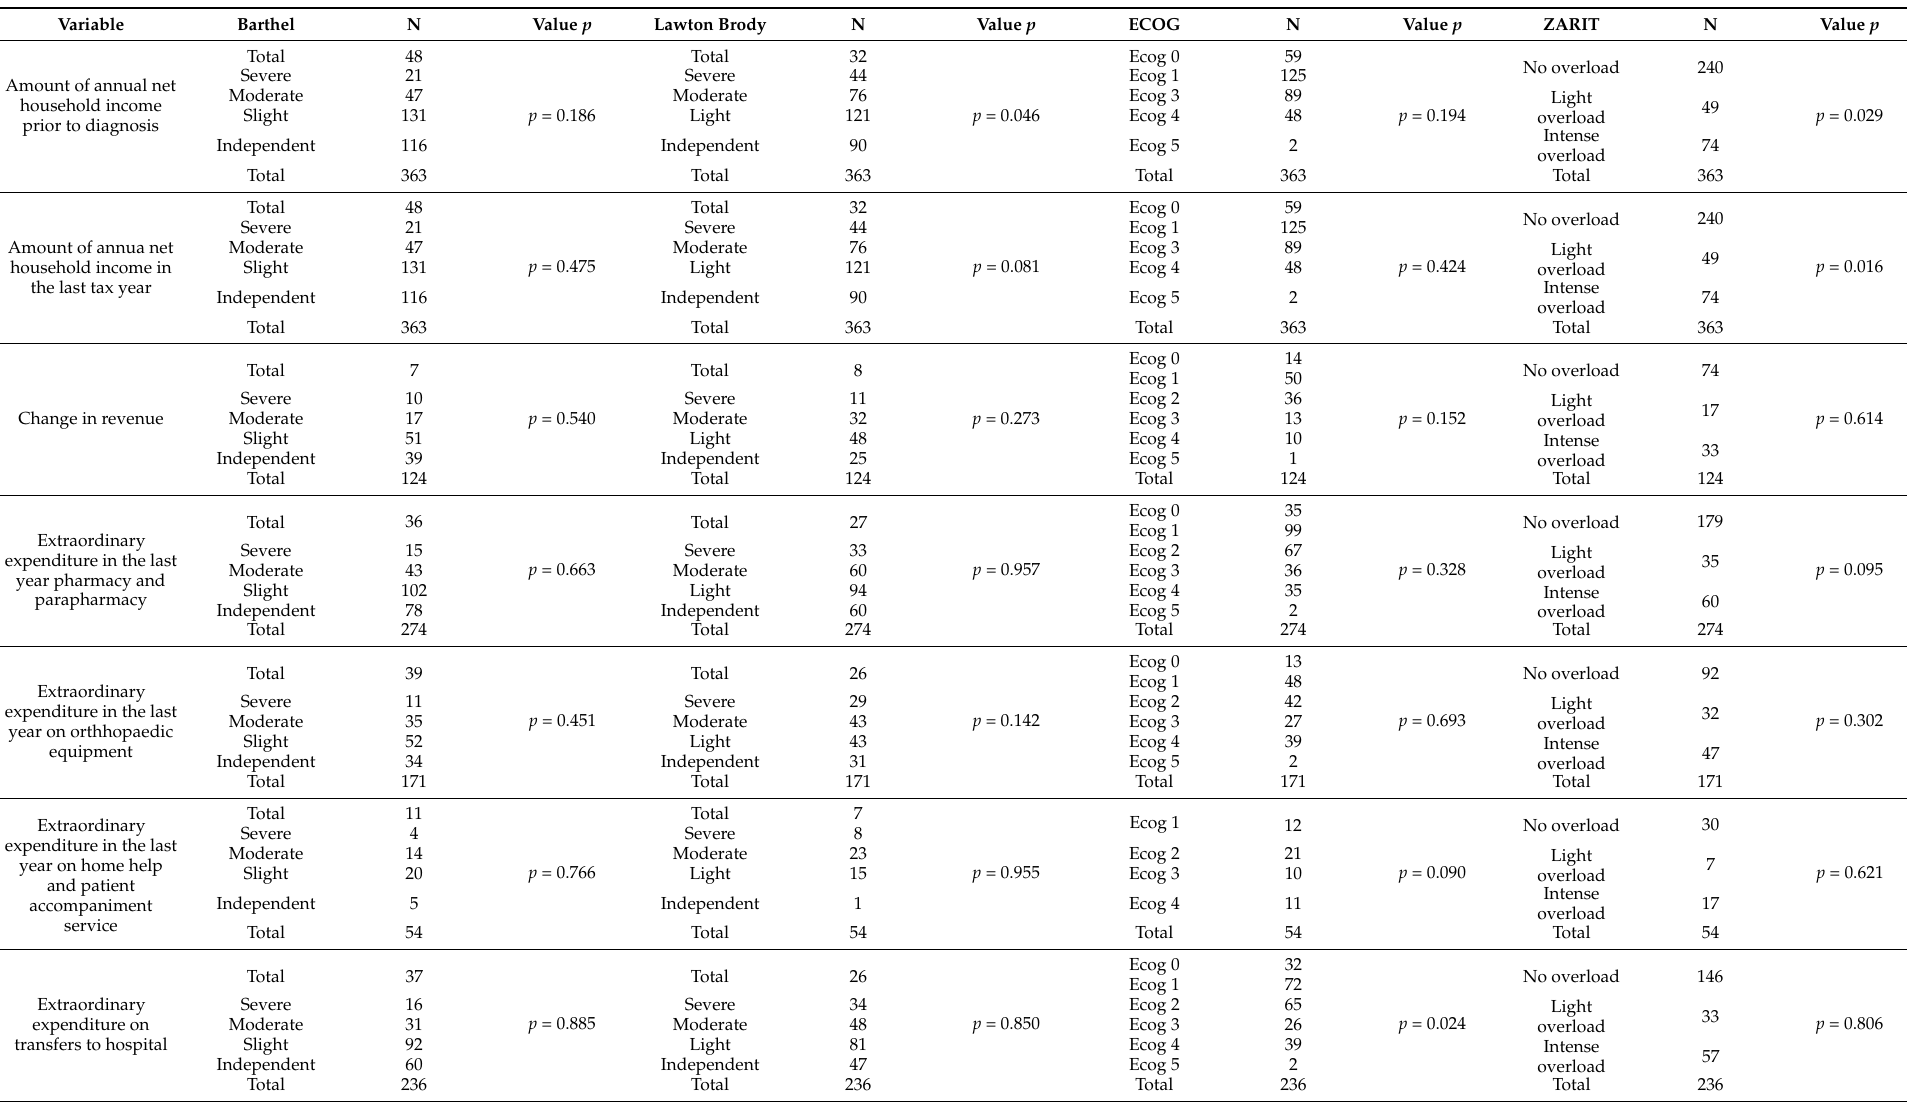
Table 4. Contrast statistics. Grouping variable: measurement